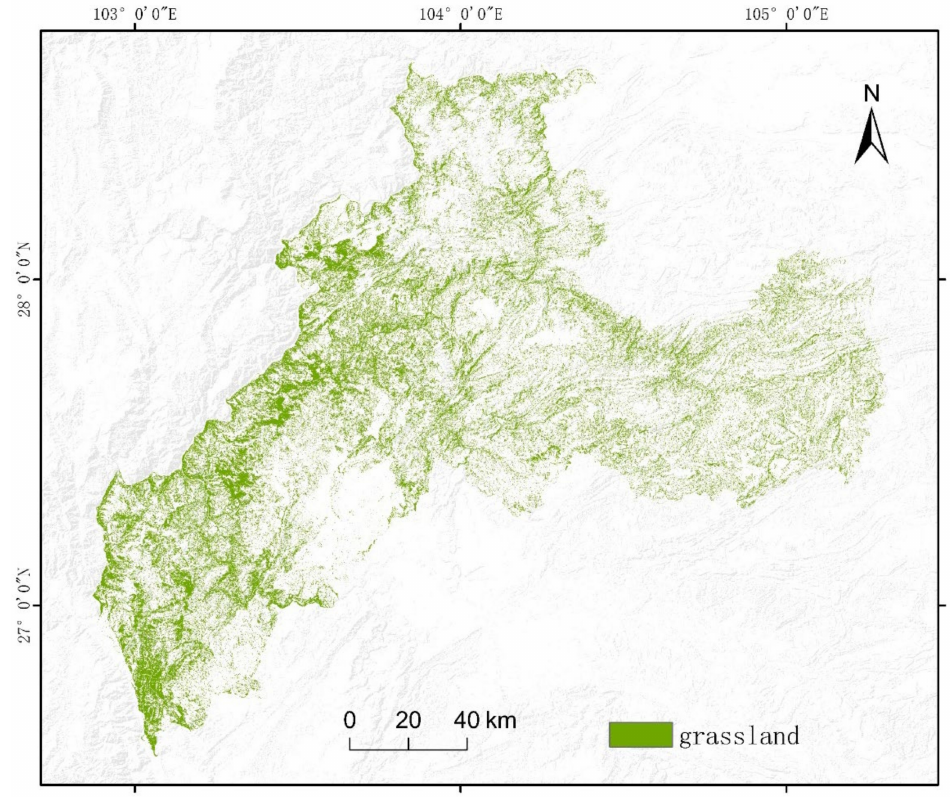
Figure 10. Grassland distribution remote sensing identification map of Zhaotong City, Yunnan Province in